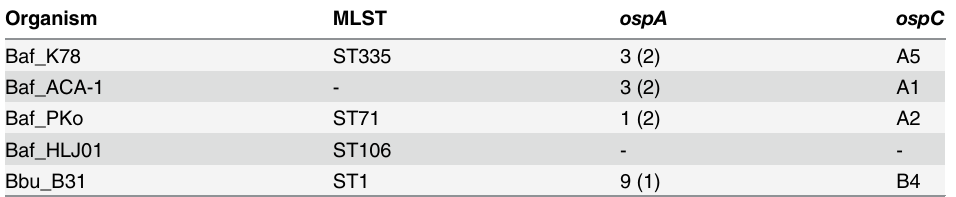
Table 1. Comparison of the sequence types of B . afzelii strains according to multi locus sequence typ- ing (MLST), and ospA and ospC typing. Organism MLST ospA ospC Baf_K78 ST335 3 (2) A5 Baf_ACA-1 - 3 (2) A1 Baf_PKo ST71 1 (2) A2 Baf_HLJ01 ST106 - - Bbu_B31 ST1 9 (1) B4 MLST typing, according to the system described by Margos et al .[54] comprising 592 de fi ned pro fi les, assigned K78 to sequence type ST335 which is identical to the Italian strains 0600839I and 05001891I in the Borrelia MLST database [55]. No match for ACA-1 and Tom3107 was found in the MLST data base with their respective sequence pro fi les. Column ospA lists the ospA sequence type from the MLSA database [56] and in parentheses the OspA serotypes. The nearest hit for Tom3107 is ospA sequence type-3 with 1 bp mismatch: ospC classi fi cation follows the scheme of Seinost et al . [57] and Lagal et al . [58]. Tom3107 do not fall into any invasive group. For strain HLJ01 only the chromosome sequence is